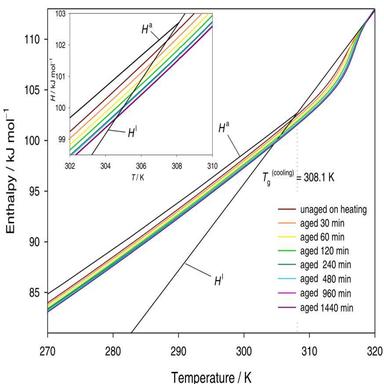
Experimental enthalpy of amorphous unaged (from cooling; Ha ), aged and liquid state (Hl ) of carvedilol as measured by DSC. Inset shows the intersection of the enthalpy of liquid (Hl ) curve and the experimental enthalpy of aged CAR.